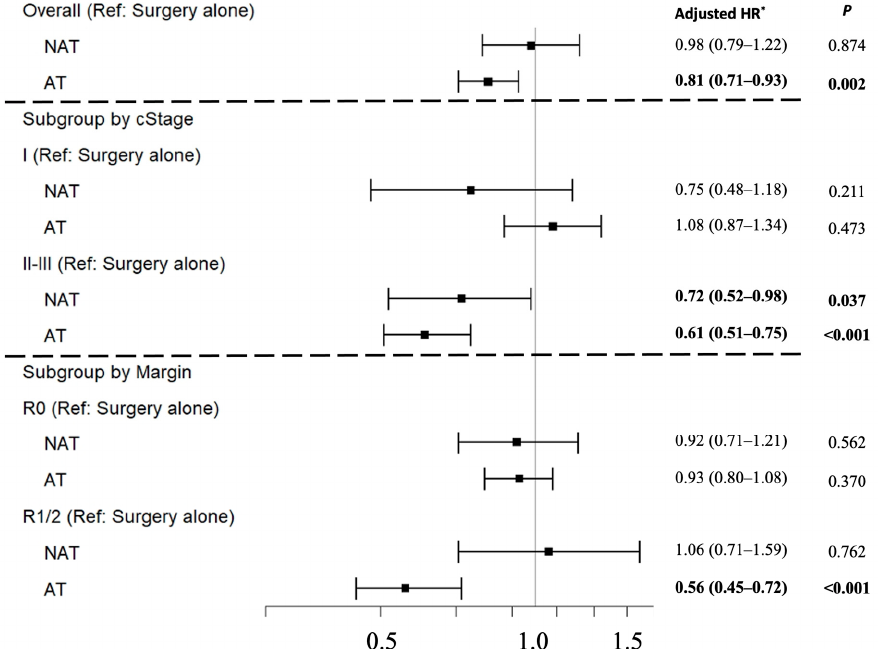
Figure 4. Comparison of overall survival by treatment strategy using risk-adjusted multivariable Cox proportional-hazards regression analyses for patients with resectable intrahepatic cholangio- carcinoma. * Model adjusted for year of diagnosis, age, gender, race, insurance status, Charlson comorbidity index, average income, average level of education, facility type and location, popula-